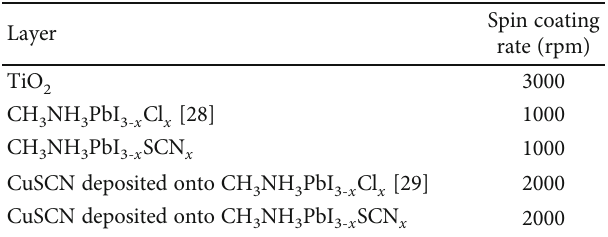
Table 2: Performance of fabricated mixed halide perovskite solar cell.